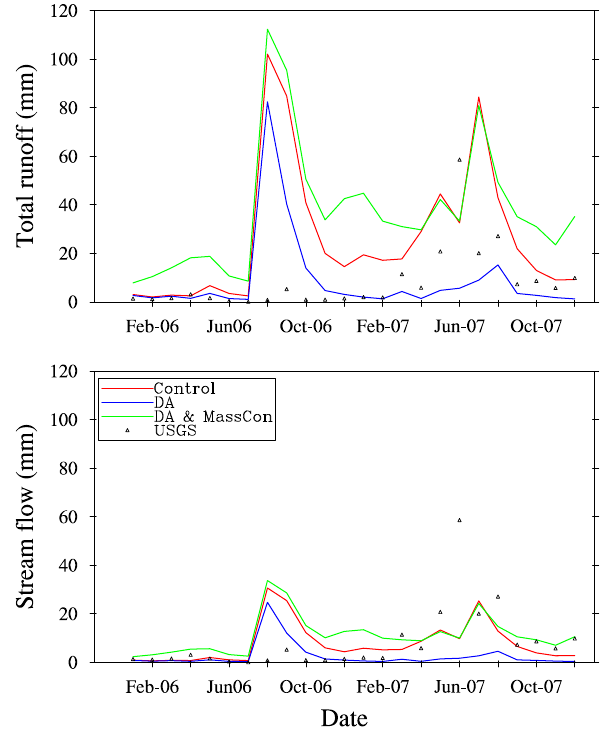
Fig. 9. Comparison of monthly total runoff (top panel) and stream flow (lower panel) from Control, DA and DA MassCon versus USGS gauge